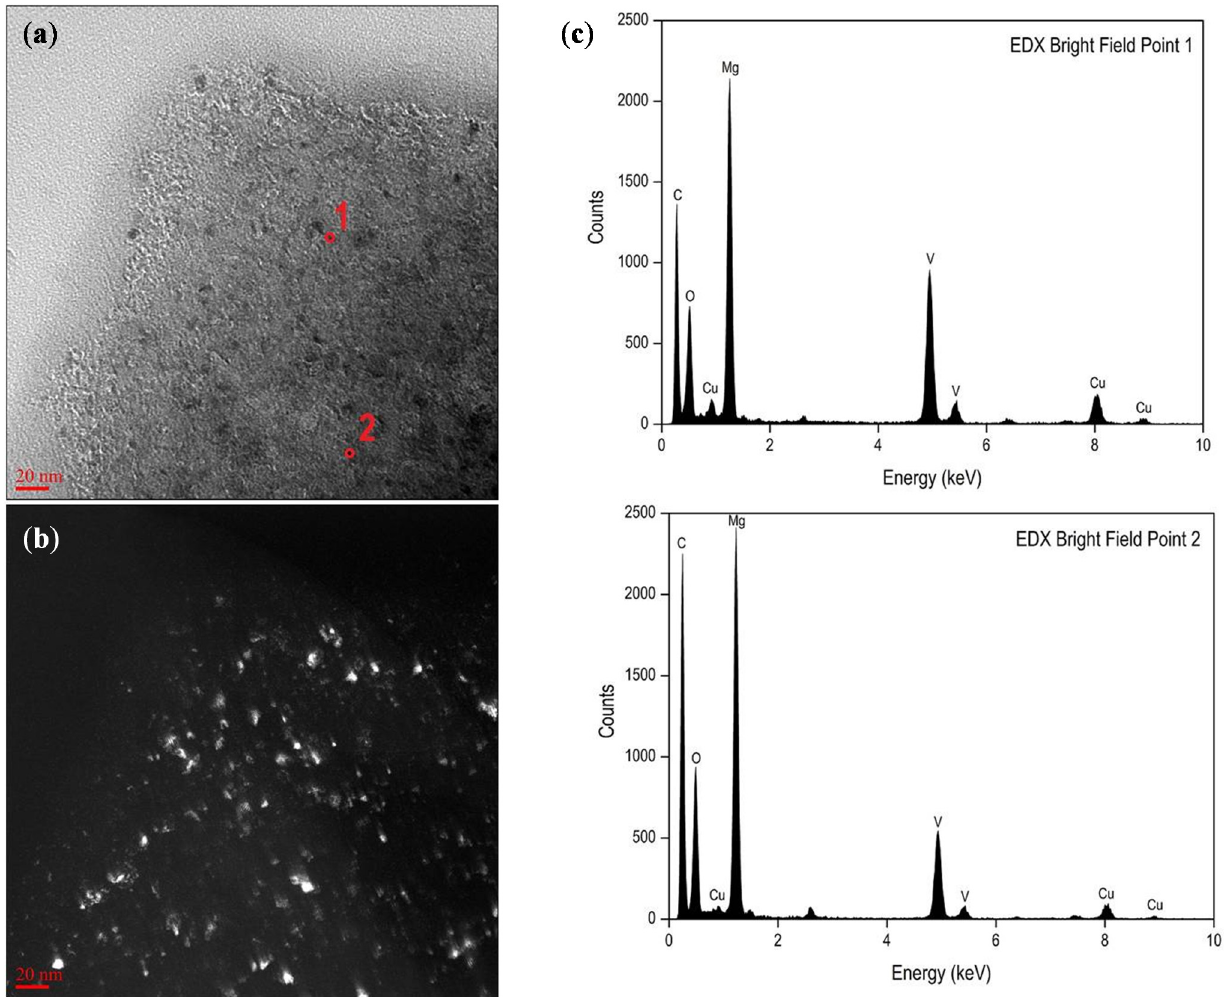
Figure 4. TEM images: ( a ) bright field; and ( b ) dark field of as milled MV(4.5)cnt(0.5); ( c ) EDX element analysis corresponding to spots on ( a